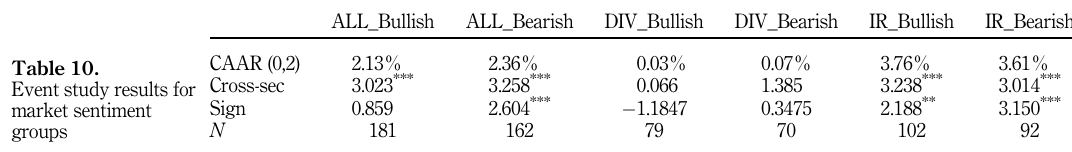
Table 10. Event study results for market sentiment